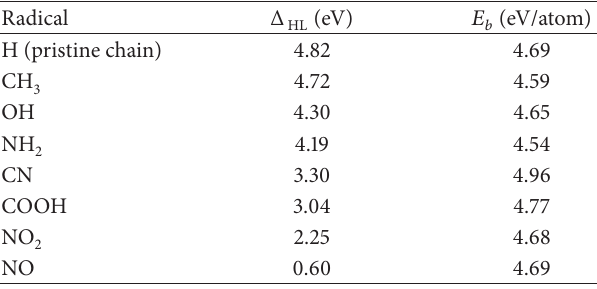
Table 2: Binding energies 𝐸 𝑏 and HOMO-LUMO gaps Δ HL for various cubane-based oligomers obtained within NTBM model.